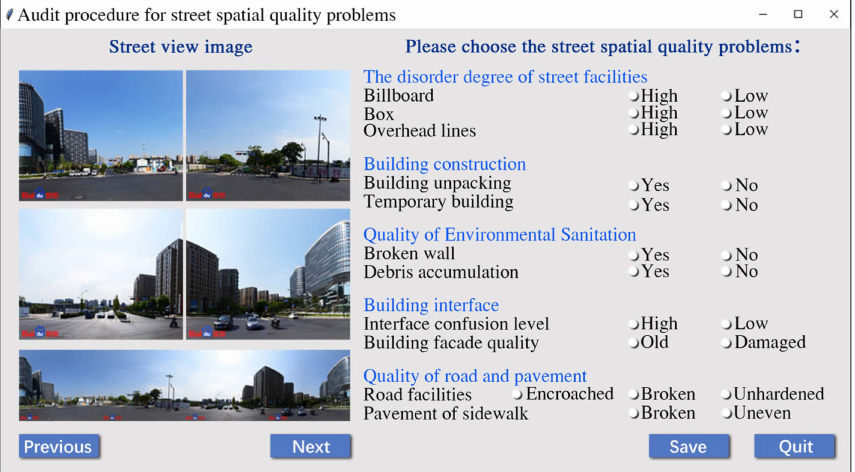
Figure 8. Audit procedure for street spatial quality